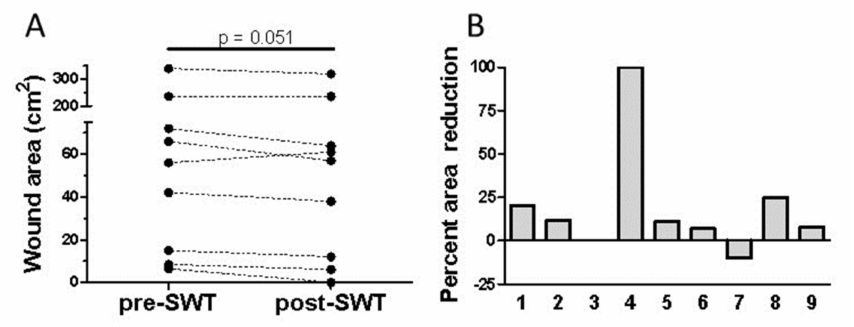
Figure 1. Extracorporeal shock wave therapy (ESWT) improves healing of chronic ulcers. ( A ) ESWT improved healing in seven out of the nine patients as determined by a decrease in total wound area (cm 2 ) from baseline before ESWT and at 2 weeks post-therapy. ( B ) Seven out of nine patients showed a decrease in the percentage area of their wound from baseline to 2 weeks post-ESWT, one patient showed no change and one patient a decrease in reduction. Numbers shown on the x-axis (1–9) represent individual